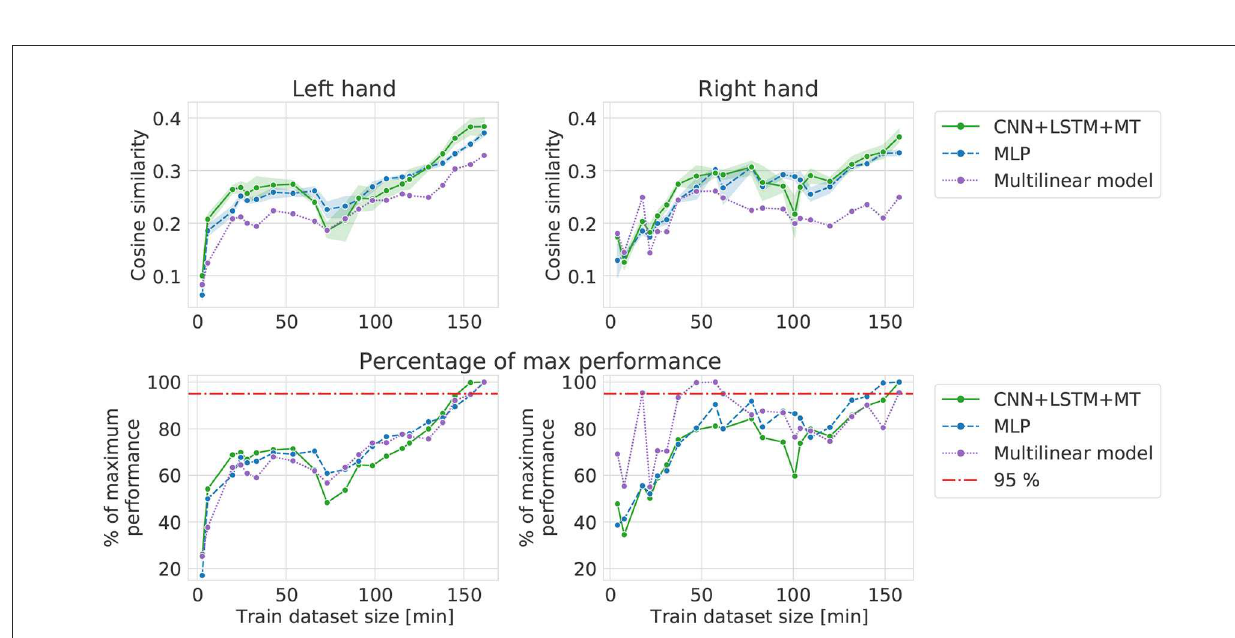
models show similar trends (see Figure 8). For the left hand, we can observe an increase in cosine similarity for datasets recorded later in the experiment suggesting an improvement in data quality. The increase is less visible for the right hand dataset. This is confirmed by the slope of the linear trend fitted to the average performance of all the models (Table 3). Expected cosine similarity improvement from training a model on the dataset recorded later was equal to 0.0069 per session and 0.0044 per session for left and right hand datasets, respectively. For both datasets, the most significant performance increase between the first and last evaluation can be observed for the multilinear model (Table 4). It may suggest that the patient, to some extent, adapted specifically to the linear model family. The multilinear model does not follow the same fluctuations as the DL methods. The difference could be caused by the way of validating models (10% validation set for DL,